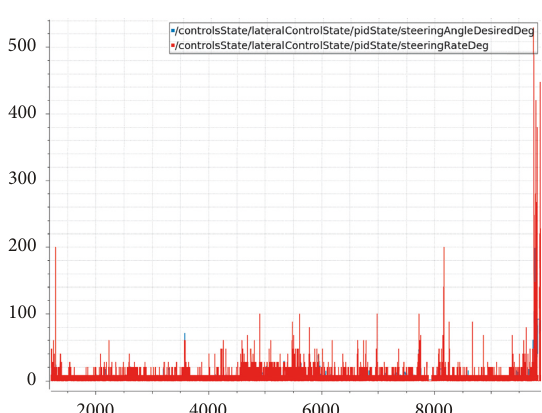
Figure 43: T2D1 steering degrees.